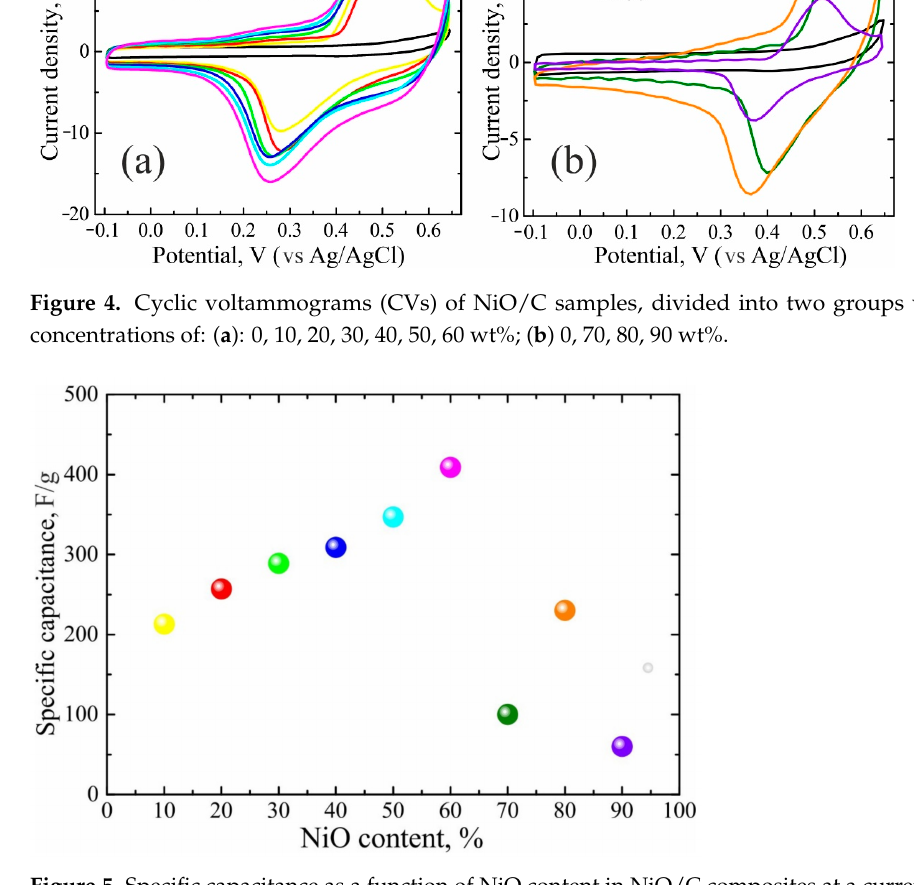
Figure 5. Specific capacitance as a function of NiO content in NiO/C composites at a current density of 0.5 F g − 1 in a three-electrode cell in a 1 M KOH solution. The results are divided into two groups.